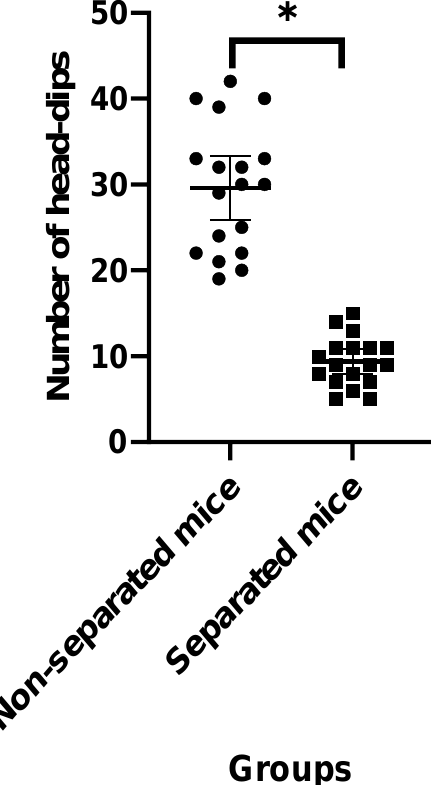
Figure 5. Number of head-dips in experimental groups. (*) indicates significant difference ( p < 0.05) between separated and non-separated mice by the unpaired t test ( n = 18/each group).